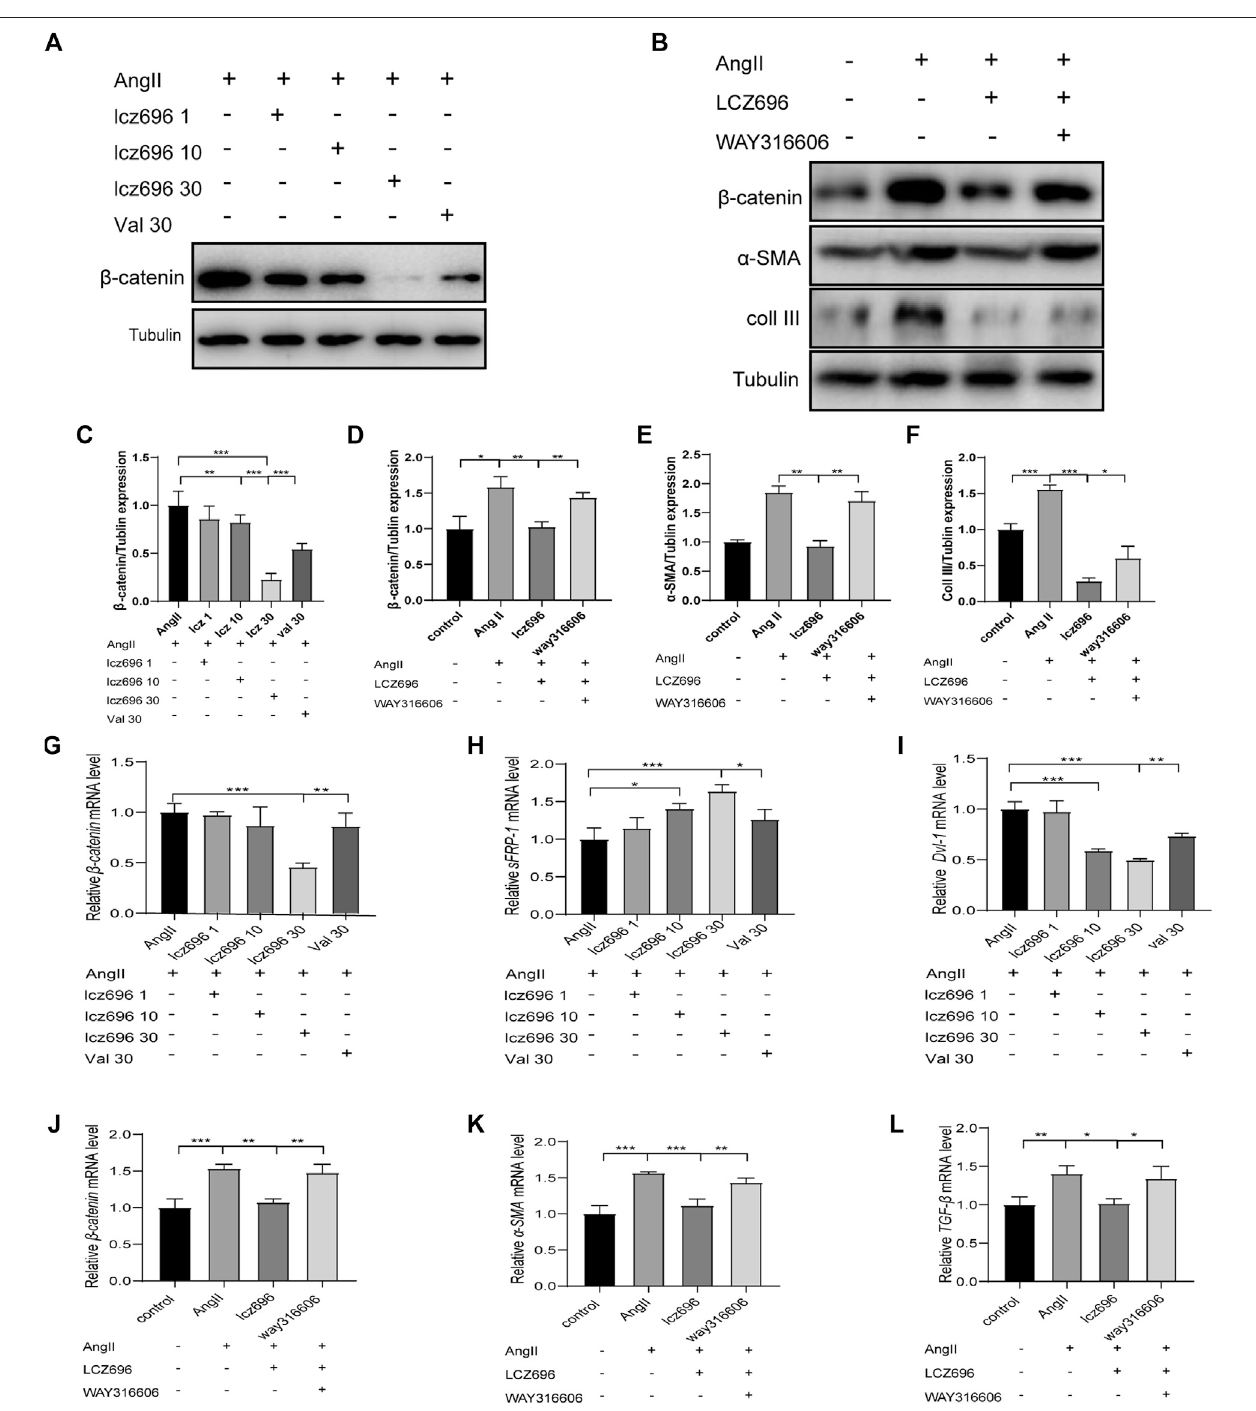
FIGURE 6 | Effects of sFRP-1 on myocardial fi brosis . (A,C) Western blot analysis of the β -catenin expression. (B,D,E,F) . Western blot analysis of the β -catenin, α -SMA and collagen III expression in the context of way316606 treatment. (G,H,I). Relative mRNA expression level of β -catenin,sFRP-1 and Dvl-1 . (J,K,L) Relative mRNA expression level of β -catenin, α -SMA and TGF- β in the context of way316606 treatment. Angiotensin II:100 nmol/L; lcz696 1 μ mol/L; lcz696 10 μ mol/L; lcz696 30 μ mol/L; valsartan 30 μ mol/L; way316606 2 μ mol/L. The experiment was conducted at least 3 times independently,* p < 0.01,** p < 0.05, *** p < 0.001.